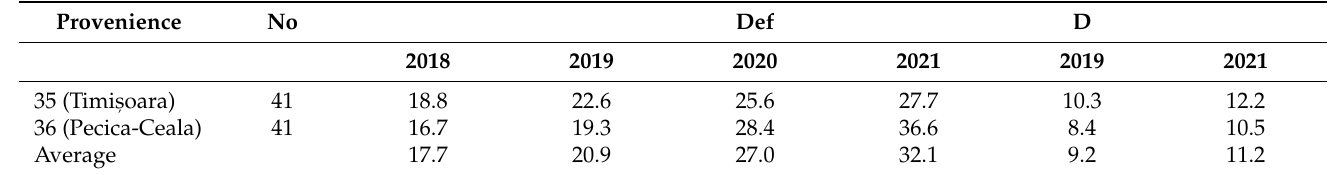
Table 6. Defoliation and diameter evolution of Ulmus laevis provenances.